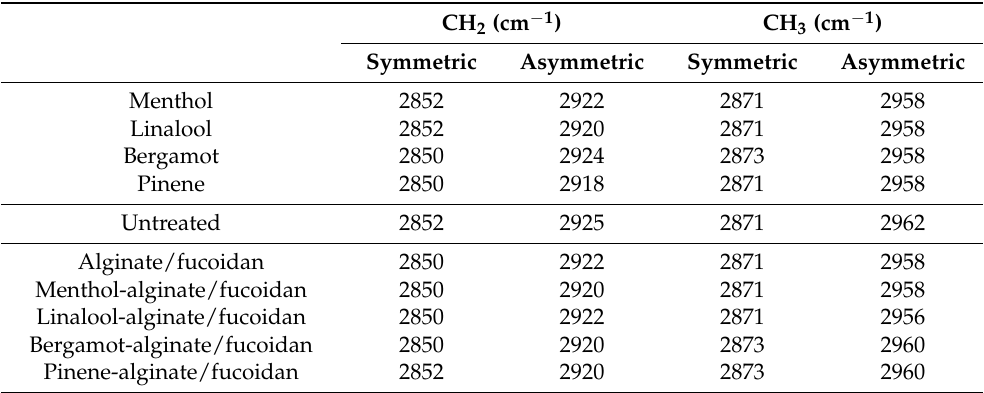
Table 1. Evaluation of the lipid CH 2 and CH 3 stretching band shifts in all essential oils and essential- oil-enriched hydrogels. CH 2 (cm − 1